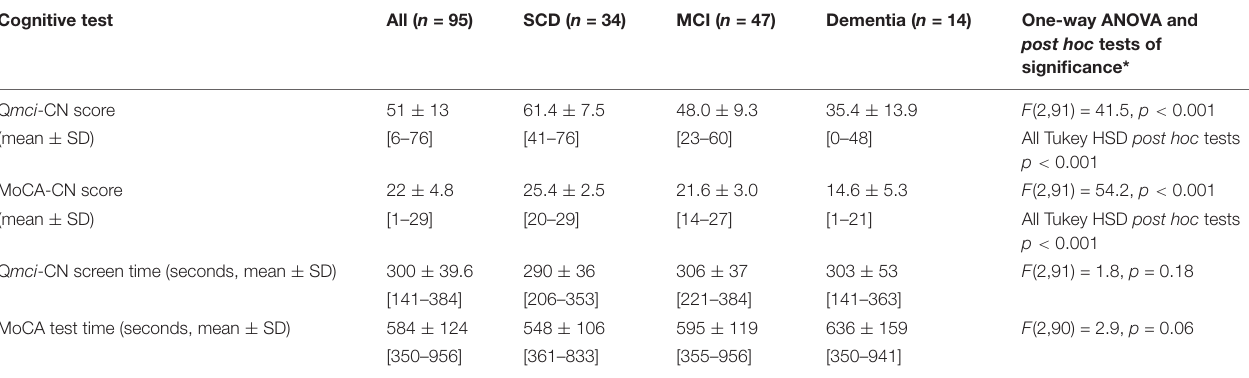
TABLE 2 | Mean test scores and administration times for the Chinese versions of the Quick Mild Cognitive Impairment screen (Q mci -CN) and Montreal Cognitive Assessment (MoCA-CN) by diagnostic group, n =